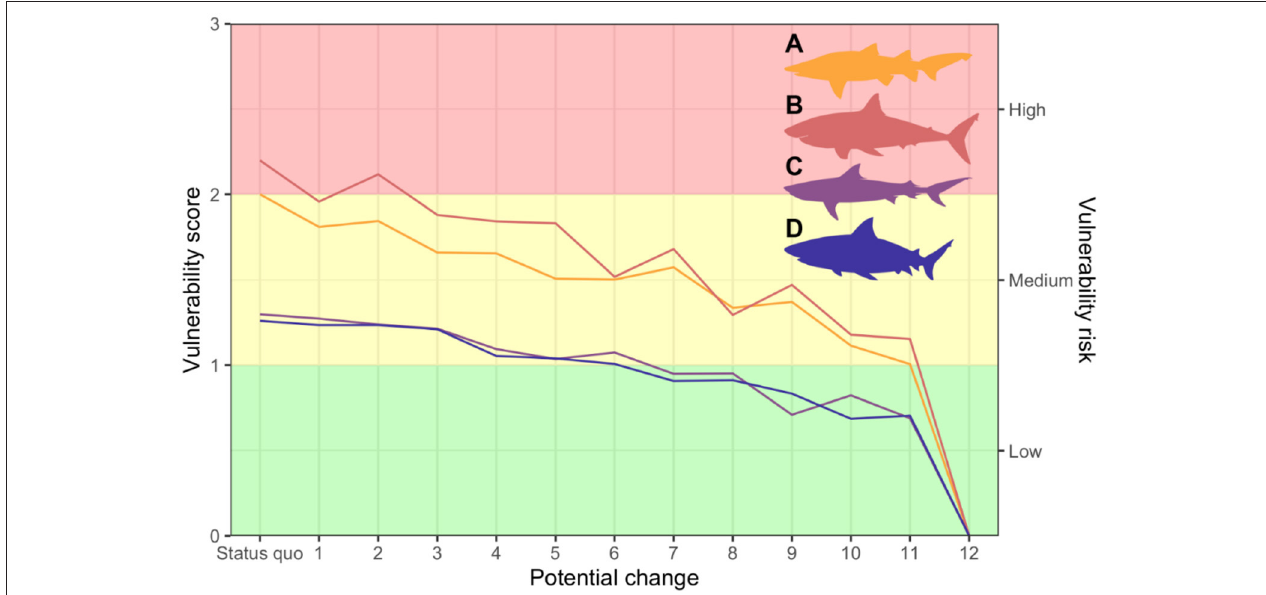
FIGURE 5 | Variation in vulnerability scores for each shark species ( A = grey nurse; B = white; C = tiger; D = bull) as a function of the potential changes identified ( Table 2 ). Background colours separate the total vulnerability score range into three groups according to the same “traffic light” pattern for vulnerability risk (green = low; yellow = medium; red = high) used for the wicked matrix ( Table 2 ).